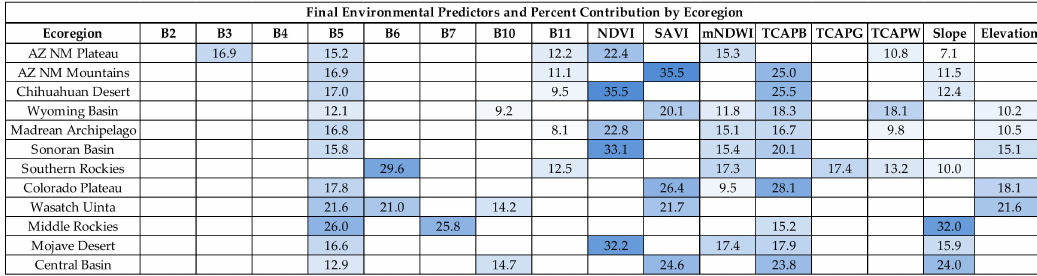
Figure 4. Final predictors included in each random forests classification model. Each row represents a separate model for the specified ecoregion. The numbers in each row are the relative percent contribution of each predictor in each individual model. White boxes with numbers represent the lowest relative contribution, light blue a medium relative contribution, and darker blue a high relative contribution. White boxes with no numbers correspond to predictors that were not retained in the final models, and therefore did not contribute to the final model. From Landsat 8; B2: Blue band; B3: Green band; B4: Red band; B5: Near infrared band; B6: Shortwave infrared 1 band; B7: Shortwave infrared 2 band; B10: Thermal infrared 1 band; B11: Thermal infrared 2 band; NDVI: Normalized Difference Vegetation Index; SAVI: Soil Adjusted Vegetation Index; mNDWI: Modified Normalized Difference Water Index; TCAP B, G, W: Tasseled cap brightness, greenness, and wetness. The random forests classification models had a median out of bag (OOB) error of 10.2% (range 4.2–28.8%), median Kappa of 0.80 (range 0.42–0.90) and class errors ranging from 5–30%